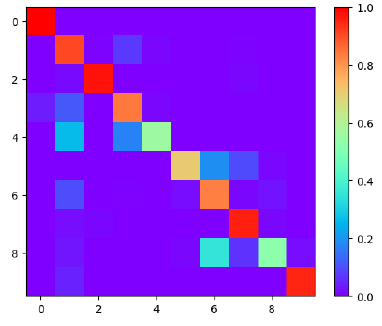
Figure 3: Matrix Confusion of Random Forest Classification Classification accuracy was assessed using global and Kappa